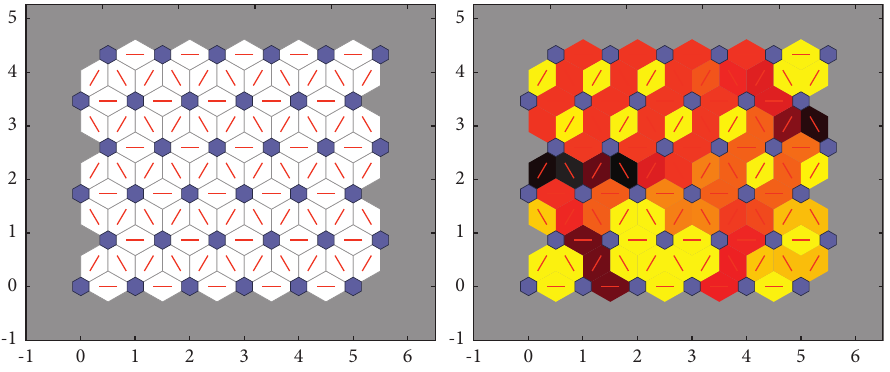
Figure 7: Neighbor connections and weight